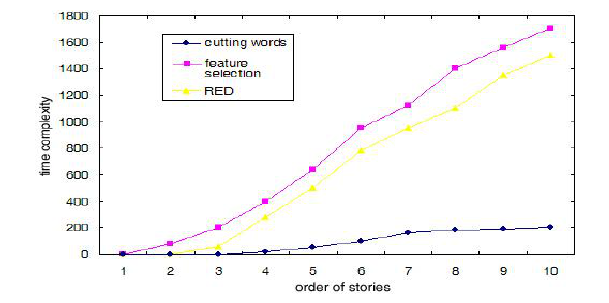
Fig. 5. Close-to-linear Time Costs of RMIR (Action of cutting words is required for stories in